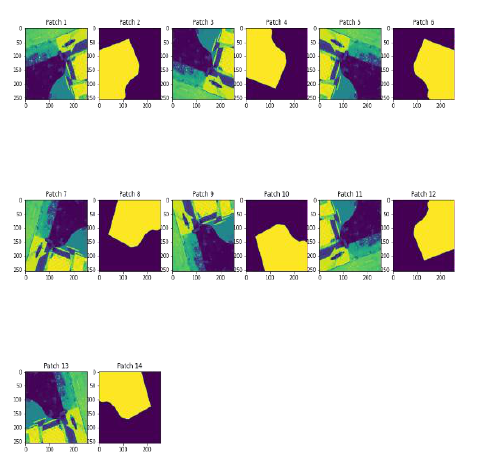
Figure 6 . Samples of data augmentation applied to a drive torque.